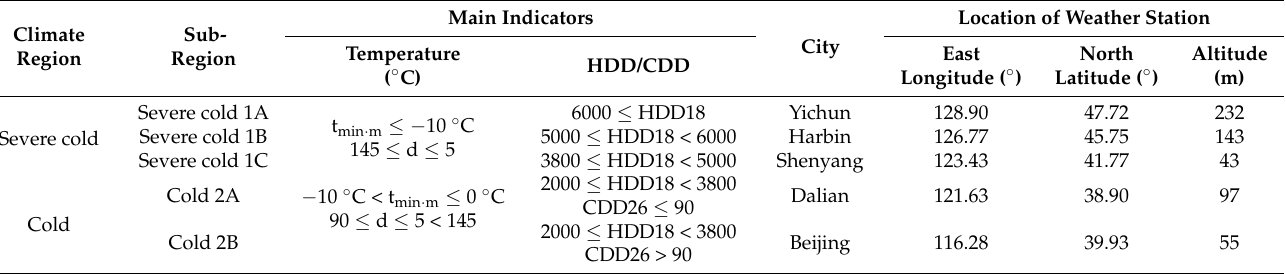
Table 2. Five cities representative of the climate sub regions.